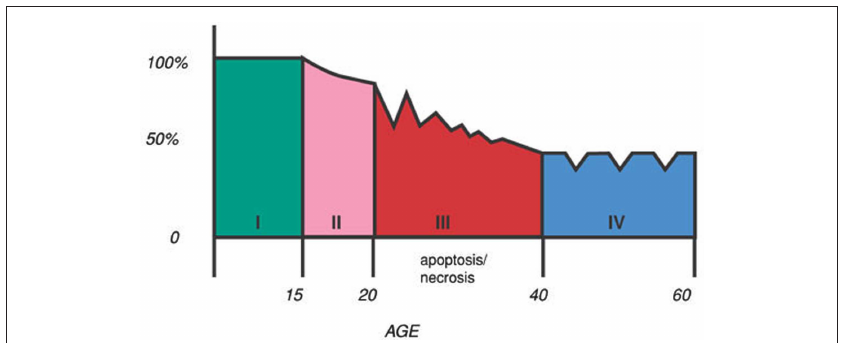
Figure 1 | Stages of schizophrenia. Stage 1. The patient is fully functional in early part of life, and is virtually asymptomatic. Stage 2. Prodromal phase starts in teens. There may be odd behaviors and subtle negative symptoms. Stage 3. The acute phase of the illness occurs in twenties or thirties, with positive and negative symptoms. Stage 4. “Burn out” phase occurs in forties or fifties with prominent negative and cognitive